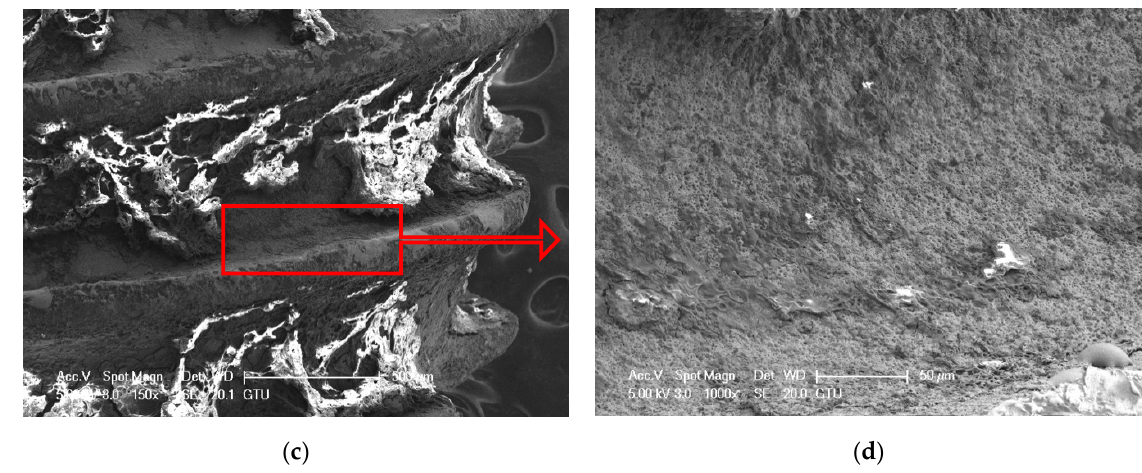
Figure 6. ( a , b ) SEM images showing the topography of untreated failed implant surfaces in ErCrL-1 group (150× and 1000×); ( c , d ) after intervention (150× and 1000×). Red arrows show the further magnification area.